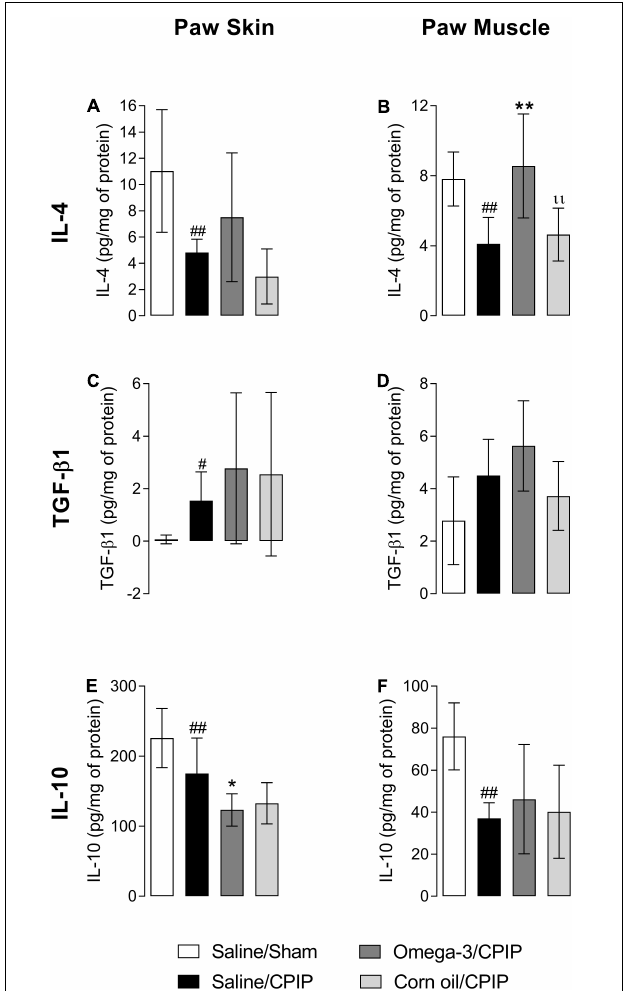
FIGURE 4 | Effects of omega-3 supplementation on the concentrations of interleukin- (IL-) 4, transforming growth factor- β 1 (TGF- β 1), and IL-10 in the skin and muscle of mice 48 h after the induction of the CPIP model. IL-4 concentrations in the skin (A) and muscle (B) of Saline/Sham, Saline/CPIP, Omega-3/CPIP, and Corn oil/CPIP groups. TGF- β 1 concentrations in the skin (C) and muscle (D) of Saline/Sham, Saline/CPIP, Omega-3/CPIP, and Corn oil/CPIP groups. IL-10 concentrations in the skin (E) and muscle (F) of Saline/Sham, Saline/CPIP, Omega-3/CPIP, and Corn oil/CPIP groups. Data are expressed as mean ± SD of 6–7 animals per group, statistically assessed by the one-way ANOVA followed by Tukey’s test. # p < 0.05 and ## p < 0.01 vs. the Saline/Sham group; * p < 0.05 and ** p < 0.01 vs. the Saline/CPIP group. ıı p < 0.01 vs. the Omega-3/CPIP group.